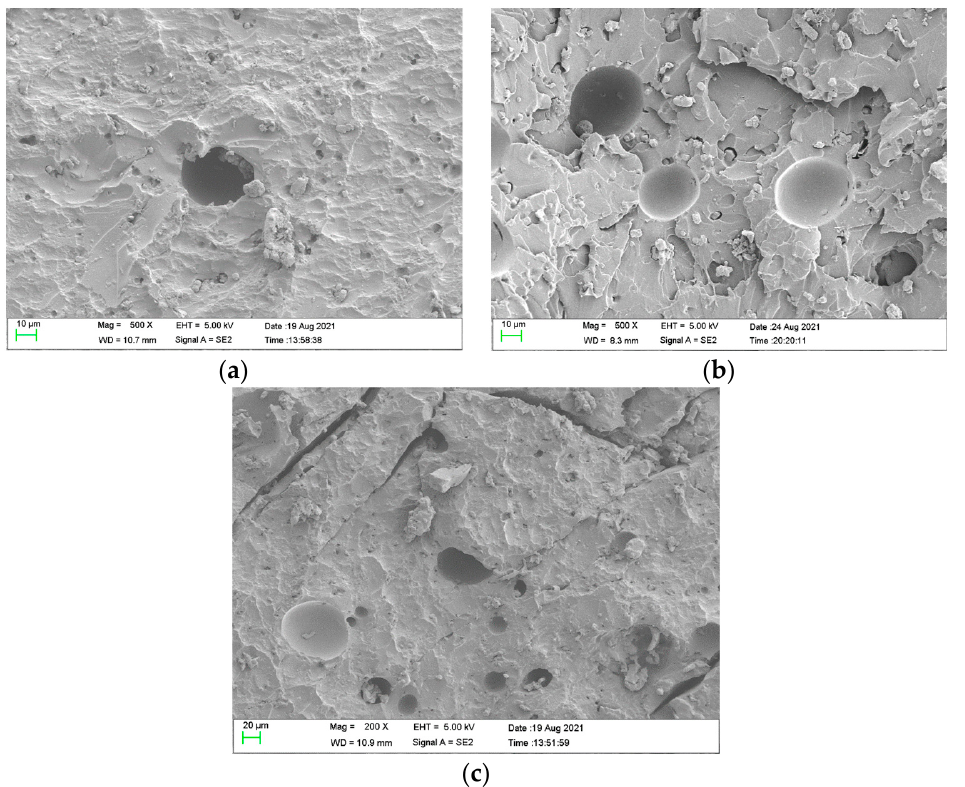
Figure 9. SEM images of polyurea on the target of configuration B1. ( a ) Debris and holes. ( b ) Brittle crack and holes. ( c ) Cracks and holes.